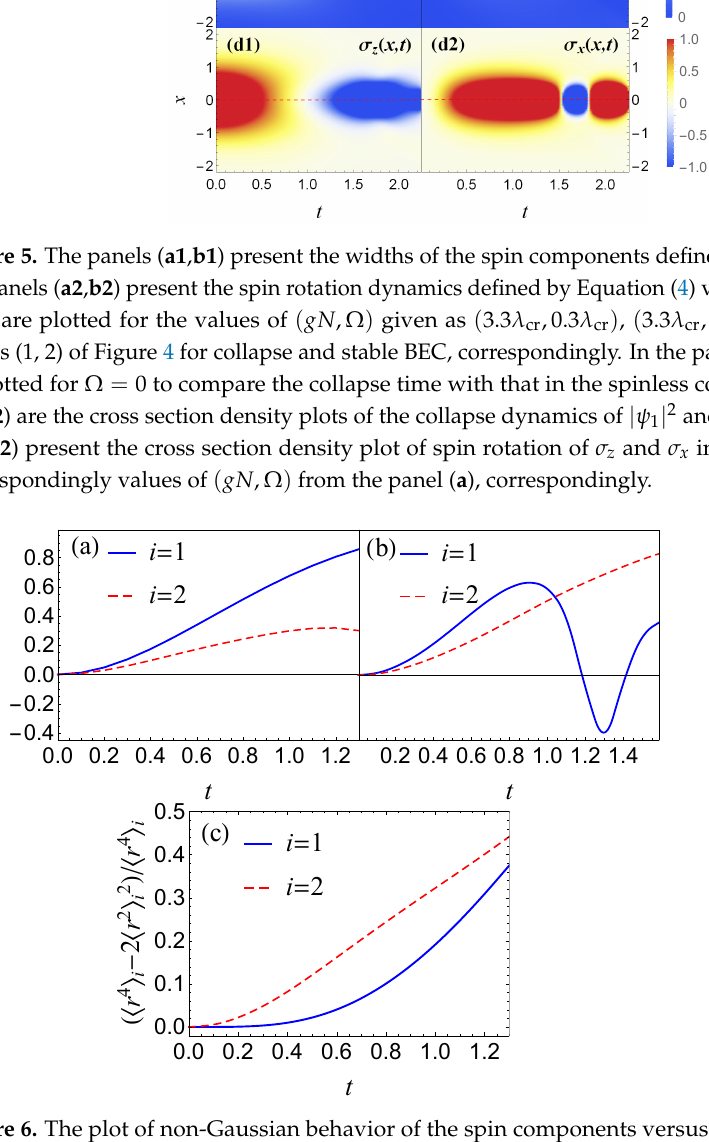
Figure 6. The plot of non-Gaussian behavior of the spin components versus time. Blue lines corre- spond to the spin up and red dashed lines corresponds to the spin down. The panels ( a , b ) correspond to intra-spin interaction with the value of ( gN , Ω ) from fixed points (1) and (2) of Figure 1, corre- spondingly. The panel ( c ) corresponds to cross-spin interaction with the value of ( gN , Ω ) from fixed points (1) of the Figure